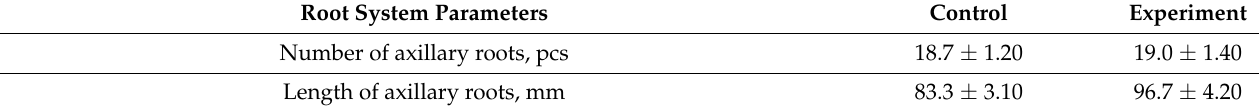
Table 3. Influence of 20% vermicompost on S. tau-saghyz axillary root development. Root System